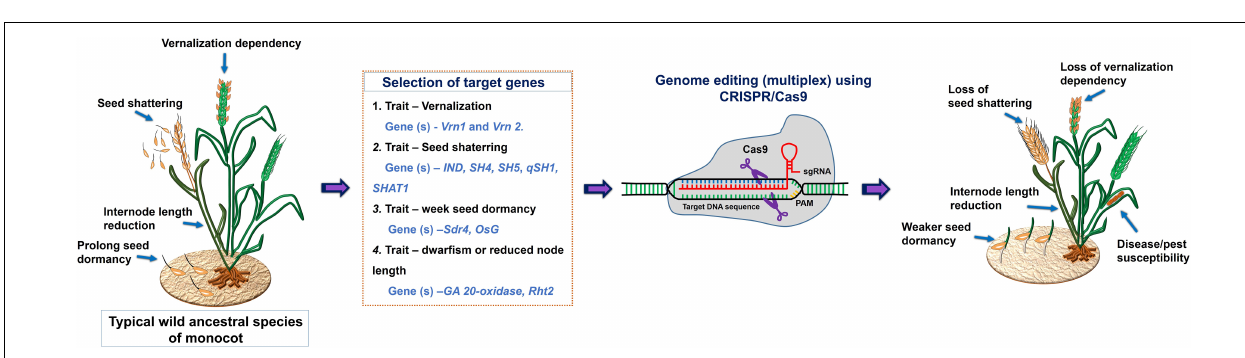
Frontiers in Genetics |